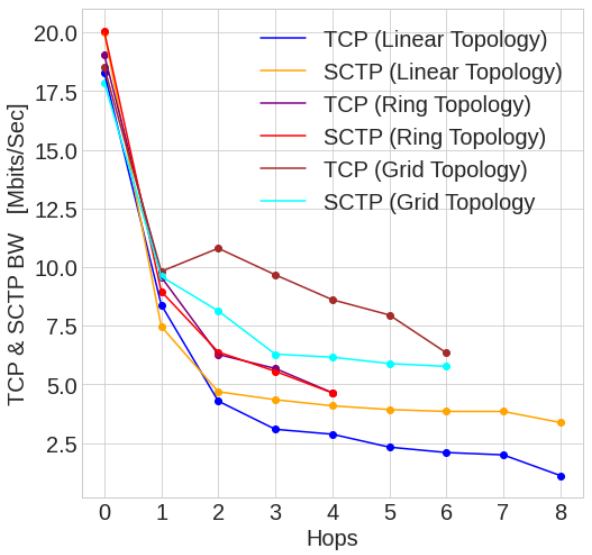
Figure 27. W-iLab2.t TCP and SCTP bandwidth.